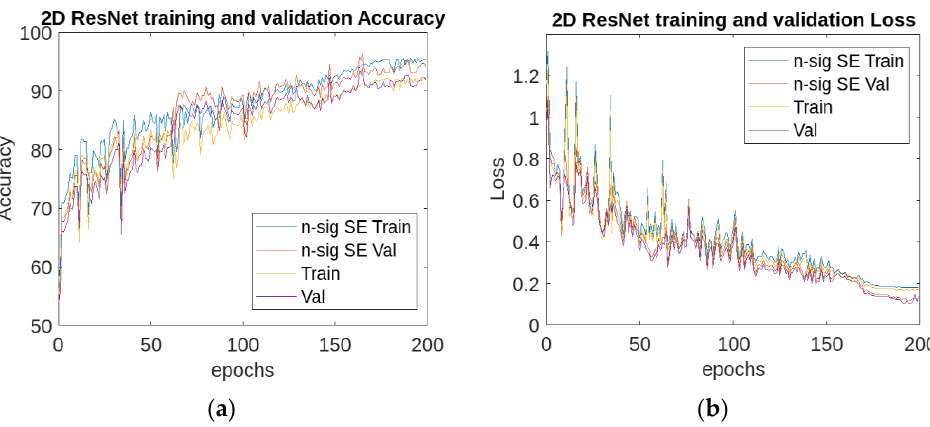
Figure 10. ( a ) Training and ( b ) validation accuracy and loss curves of the SE ResNet and the n-sigmoid SE ResNet.